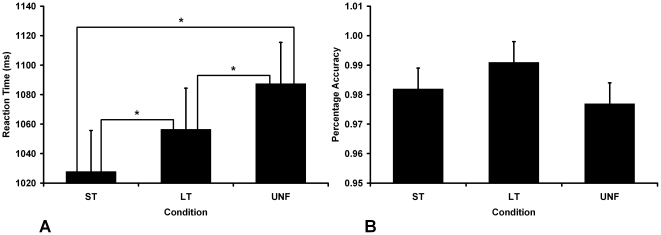
Facilitation effects in behavioral data.
A. Mean reaction times and standard errors for each condition. B. Mean percentage accuracy for each condition. Significant differences were found between all conditions for naming latency (p<0.05). No significant differences were identified between conditions for percentage accuracy. Error bars indicate standard error mean.